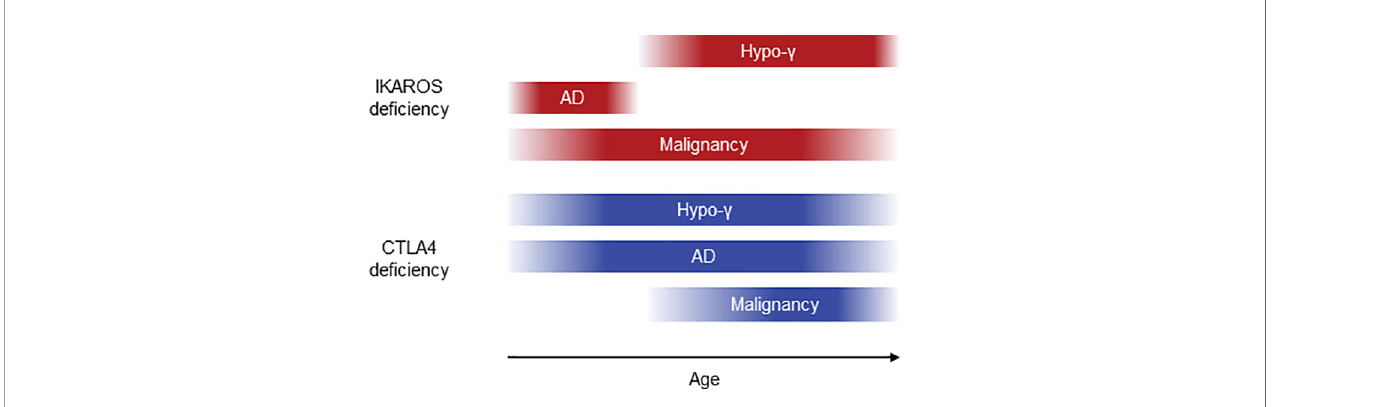
FIGURE 5 | Schematic diagram of clinical courses in IKAROS and CTLA4 de fi ciencies. AD, autoimmune disease; hypo- g